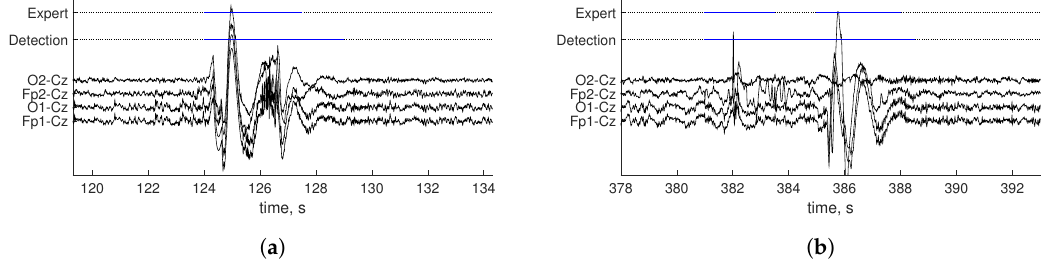
Figure 3. Examples of comparison of human scoring and artifact detection ( a , b